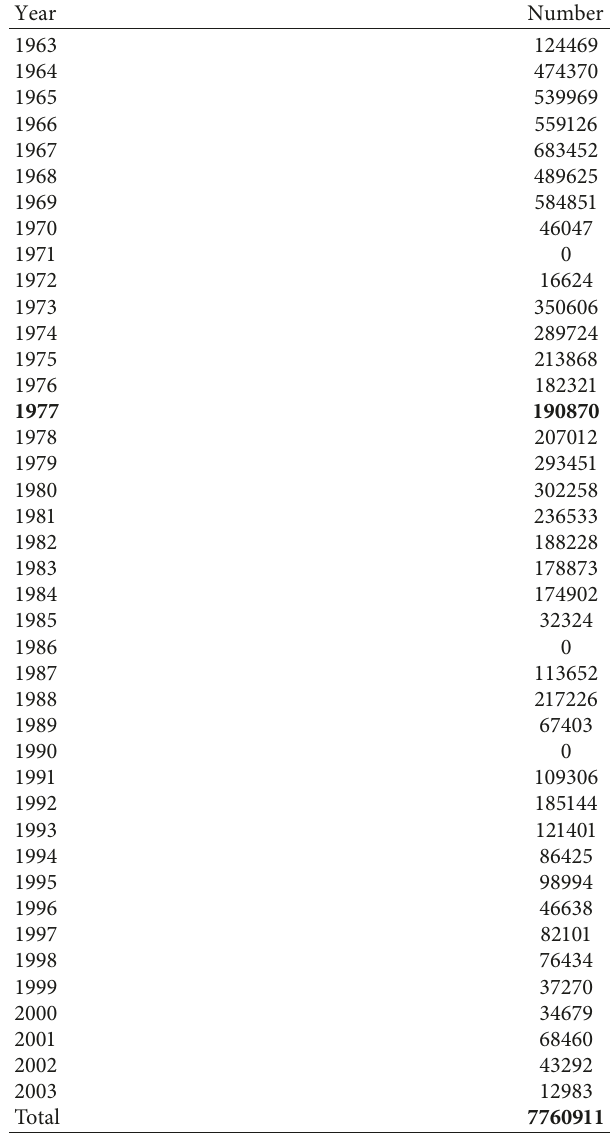
Table 5: Annual total amount of